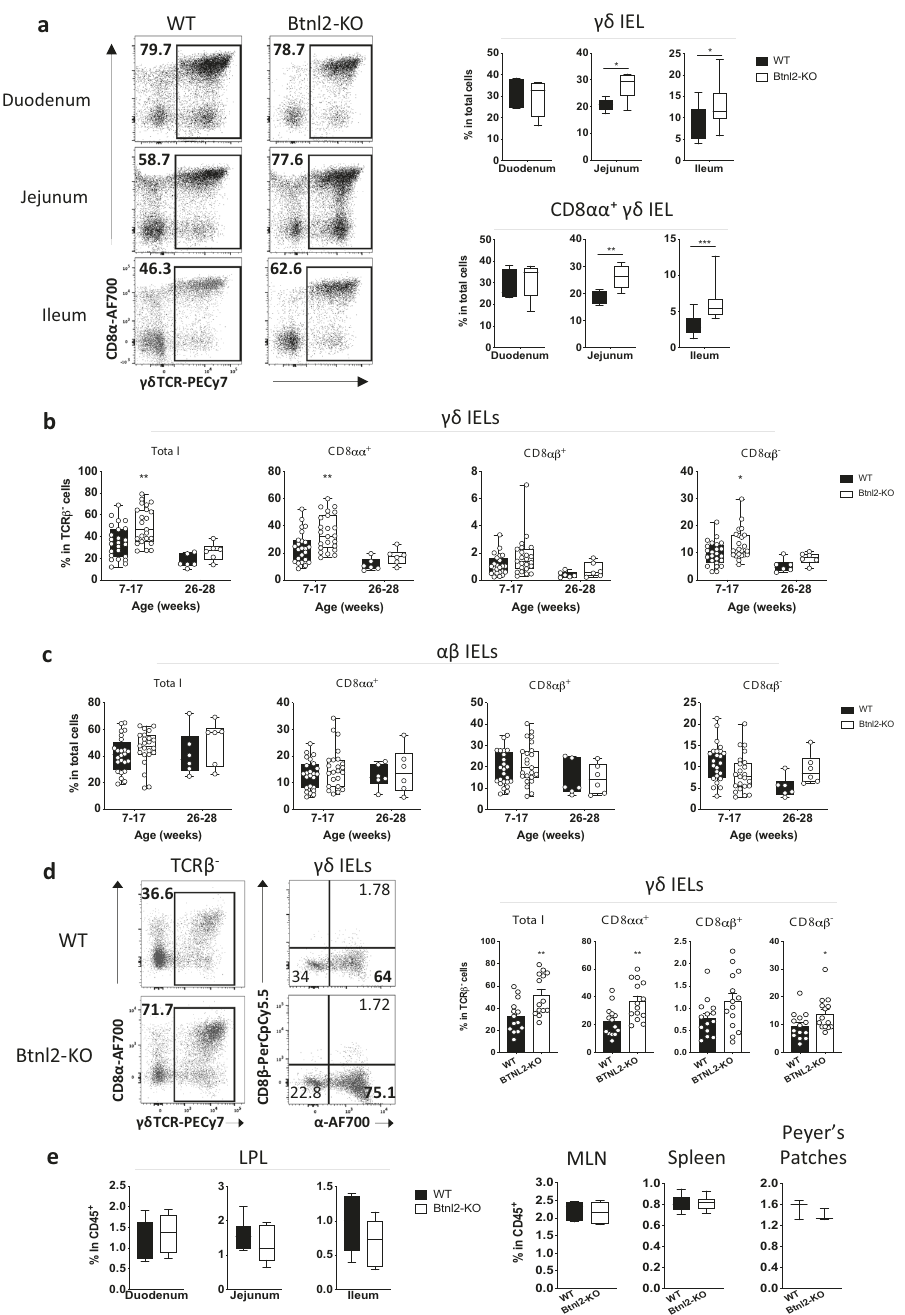
Fig. 2 Btnl2-KO mice display increased frequencies of γδ IELs in the ileum. a Different segments of the small intestine were collected from cohoused 7 – 17-week-old Btnl2-KO and WT mice ( n = 3 – 8, each) and processed for fl ow cytometry. Left panel-representative fl ow cytometry plots of γδ IELs in the duodenum, jejunum, and ileum of cohoused 7-week-old Btnl2-KO and WT littermates. Displayed plots are gated on live TCR αβ - cells. Right panel- frequencies of γδ IELs and CD8 αα + γδ IELs from 7 – 17-week-old Btnl2-KO and WT littermates. b Frequencies of ileal γδ IELs at different ages ( n = 6 – 23 mice/group). Error bars represent mean ± SEM. Signi fi cance is measured by 2-way ANOVA with Sidak ’ s multiple comparison test, * p < 0.05, ** p < 0.005. c Frequencies of ileal αβ IELs at different ages ( n = 6 – 23 mice/group). Error bars represent mean ± SEM. Signi fi cance is measured by 2-way ANOVA. d Ileum was collected from cohoused Btnl2-KO and WT littermates of different ages and intestinal intraepithelial lymphocytes (IELs) were isolated and processed for fl ow cytometry. Left panel-representative fl ow cytometry plots of γδ IELs in the ileum of 12 – 17-week-old Btnl2-KO and WT littermates. Right panel-frequencies of ileal γδ IELs from 12 – 17-week-old Btnl2-KO and WT littermates. Data are pooled from 3 independent experiments with 3 – 6 mice/ group. Error bars represent mean ± SEM. Signi fi cance is measured using unpaired t -tests assuming similar SD, * p < 0.05, ** p < 0.005, signi fi cantly different from WT mice. e Frequencies of γδ T cells in lamina propria (LP), mesenteric lymph nodes (MLN), spleen, and Peyer ’ s Patches of 7 – 17-week-old Btnl2-KO and WT littermates ( n = 3 – 6